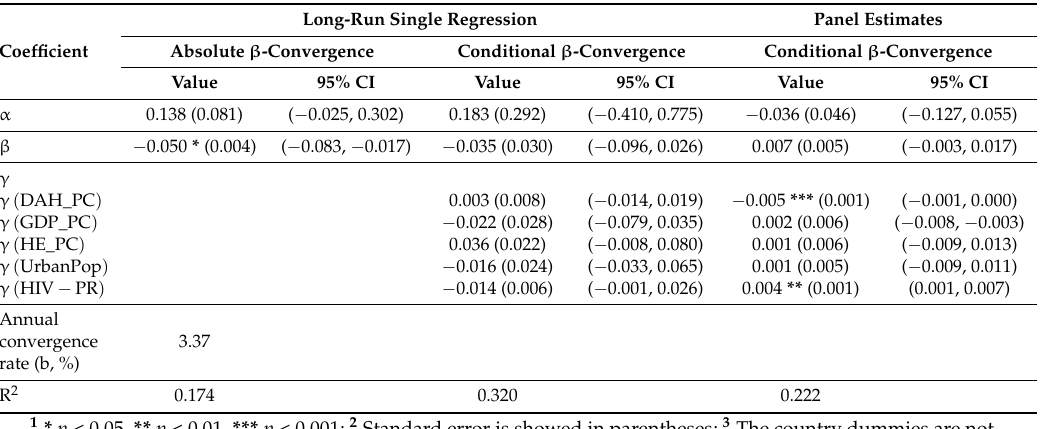
the table; 4 β = (cid:2869)(cid:2879)(cid:3032)